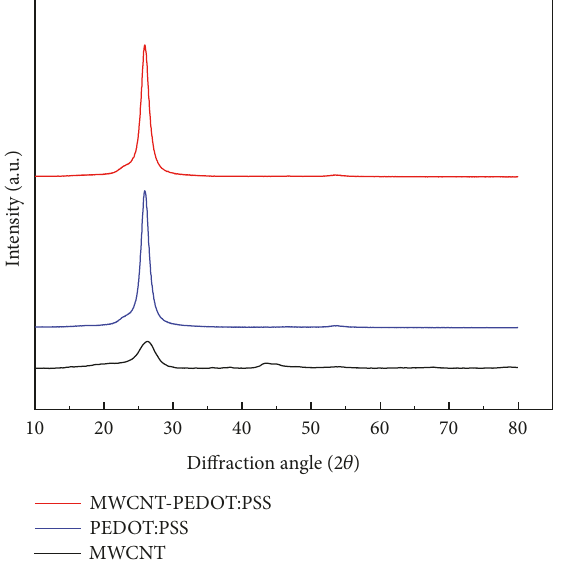
Figure 2: X-ray Diffraction of MWCNT, PEDOT:PSS and MWCNT-PEDOT:PSS nanocomposite thin